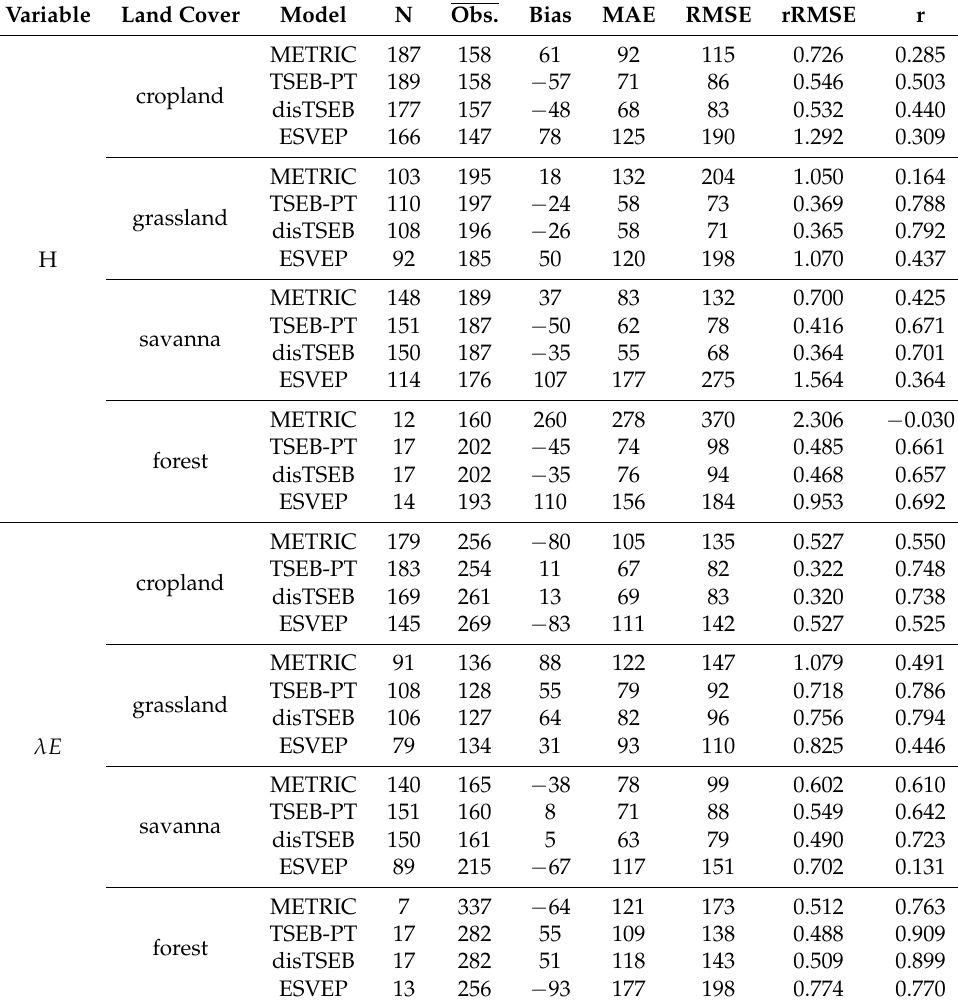
Table 5. Error dependence on land cover for METRIC, TSEB-PT, disTSEB (TSEB-PT with flux disaggregation) and ESVEP modelled fluxes using Decision Trees sharpened temperatures. N, number of valid cases; Obs.; mean of observed values (W m − 2 ); bias, mean difference between predicted